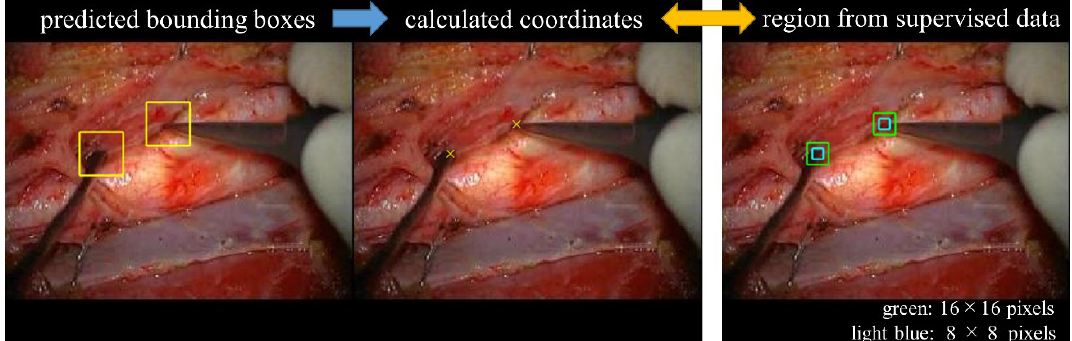
Figure 6. Process to calculate the detection rate of the distal end of the surgical instrument.